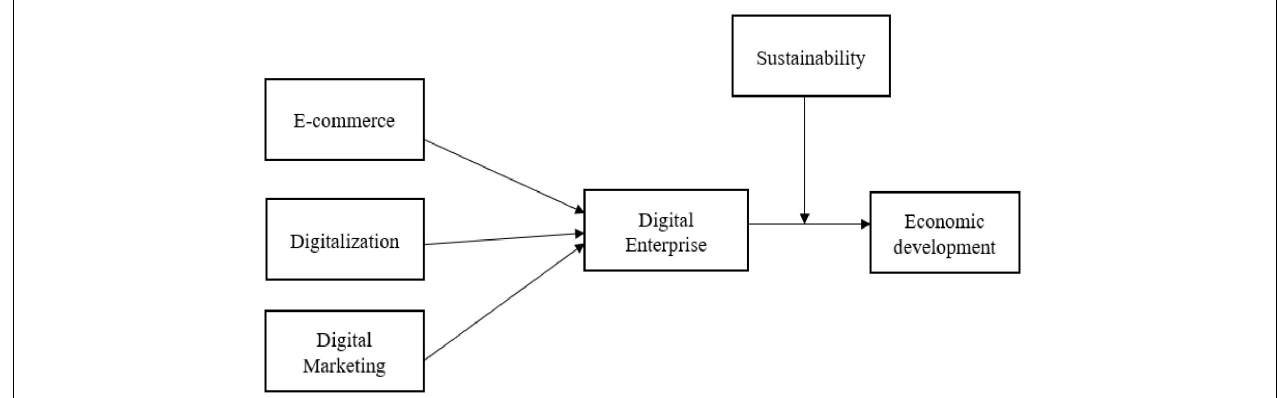
FIGURE 1 | Conceptual